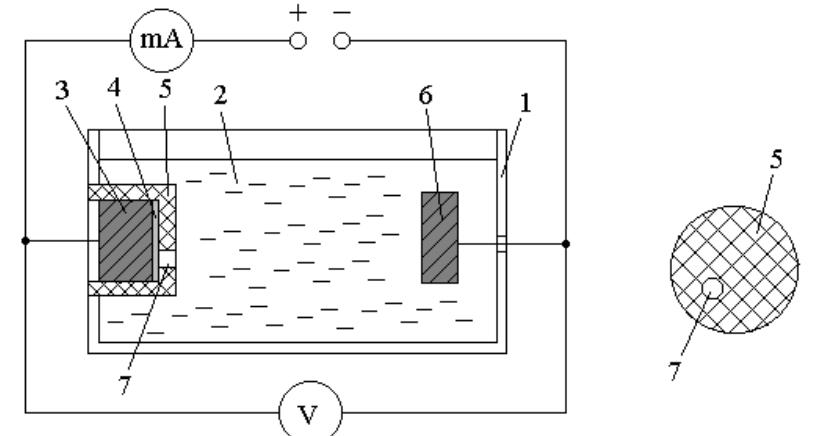
Figure 1. Potential and speed of corrosion measurement scheme: 1 – vessel; 2 – electrolyte; 3 – sample connected as anode; 4 –oxide layer; 5 – rubber gasket; 6 – cathode; 7 – hole for contacting the oxidized surface with the electrolyte in the water